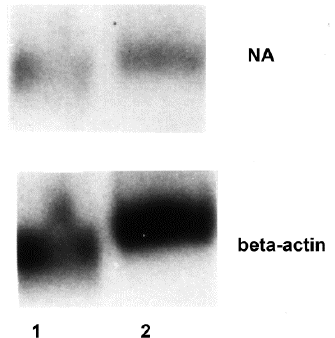
Figure 3. Influenza virus infection of purified lymphocyte subpopulations. Northern blot autoradiograms of lysates of CD4 + (lane 1) and CD8 + (lane 2) T lymphocytes are shown. The cells were exposed to influenza virus in the presence of monocytes-macrophages (that is, as PBMC) and then purified as described in Materials and Methods. Lysates were probed for influenza virus neuraminidase (NA) and the same lanes were probed subsequently for β-actin.